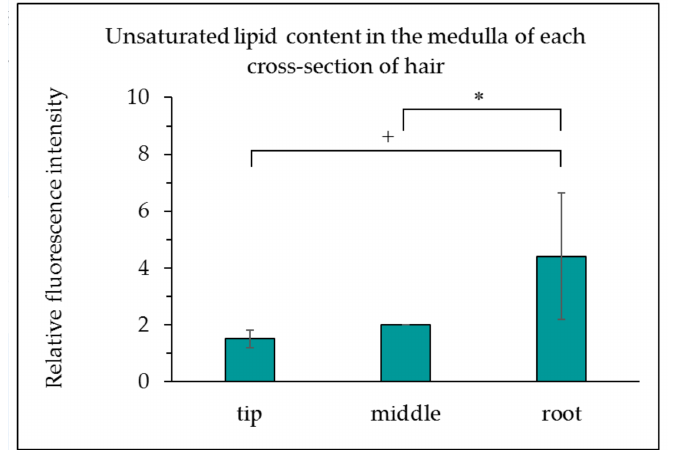
Figure 2. Unsaturated lipid content in the medulla of each cross-section of hair. The results are expressed as the mean ± standard deviation from three experiments. ∗ p < 0.05, + p < 0.1.